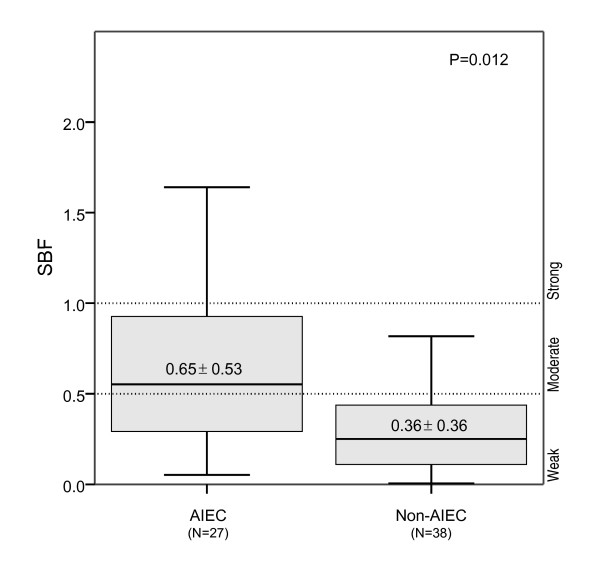
Mean specific biofilm formation (SBF) index of AIEC and mucosa-associated non-AIEC strains. The mean SBF index was higher for AIEC than for non-AIEC strains, as corroborated by one-way ANOVA (P = 0.012).